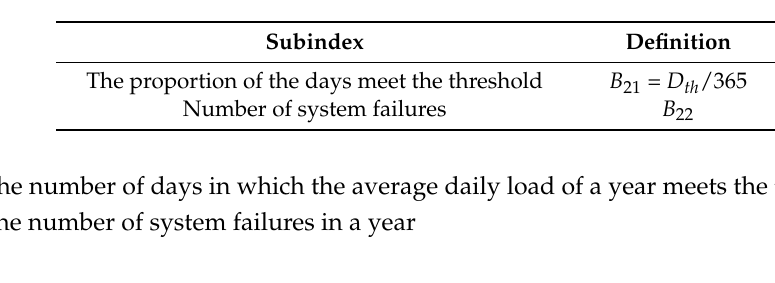
Table 4. Definition of reliability of WG and